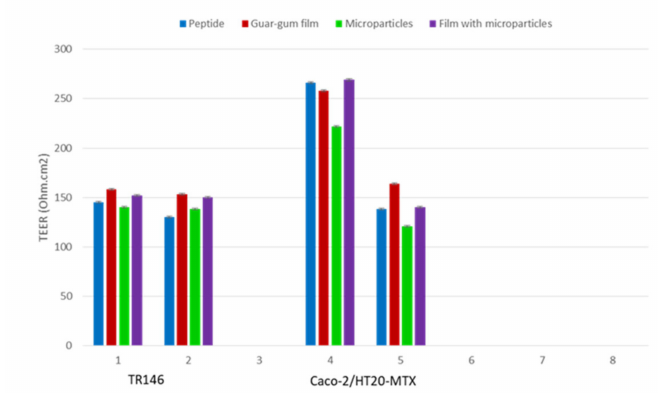
Figure 4. TEER cell monolayer TR146 and co-culture Caco-2/HT29